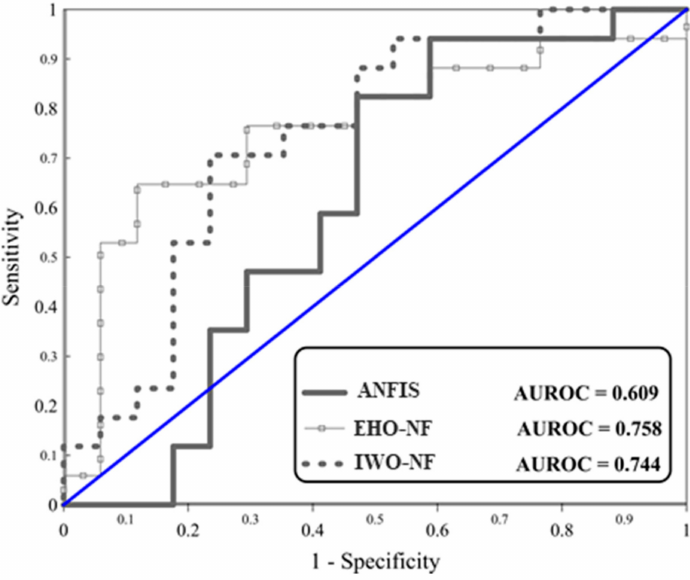
Figure 6. The ROC diagrams for the used models. Table 3. The results of the statistical analysis of testing ROC